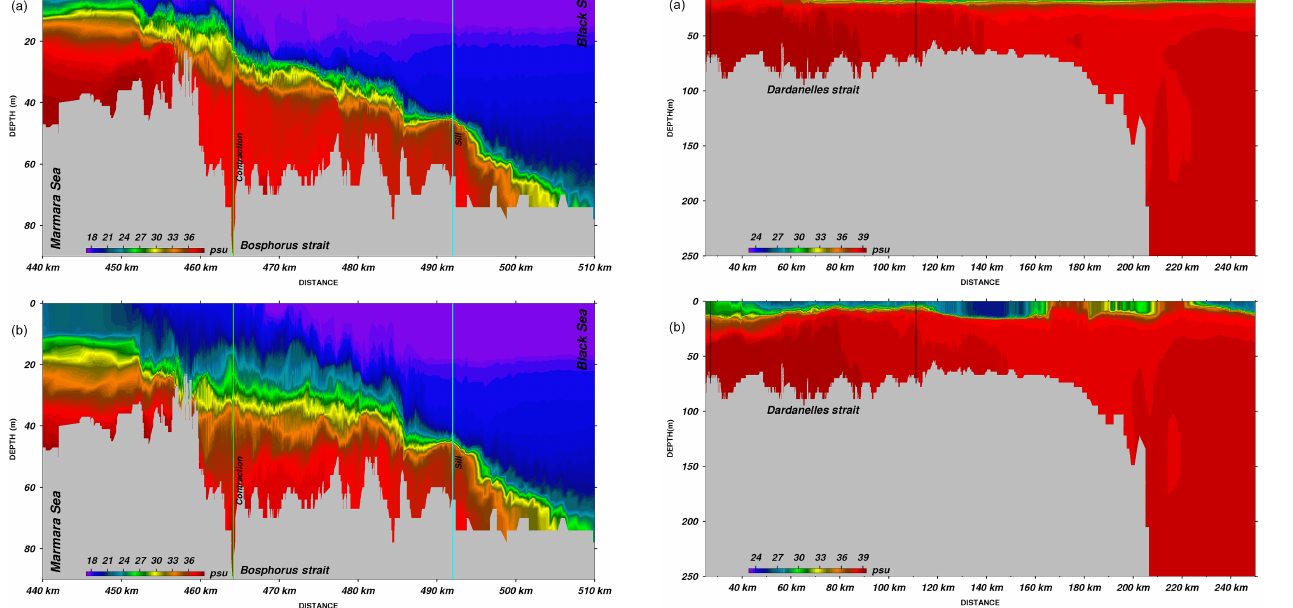
Figure 12. Cross-section of salinity in the Bosphorus strait on (a) 15 November and (b) 22 November 2008 along the thalweg between 440 and 510km. Contraction and the northern sill loca- tions are marked with green and cyan lines, respectively, as shown in Fig. 1.